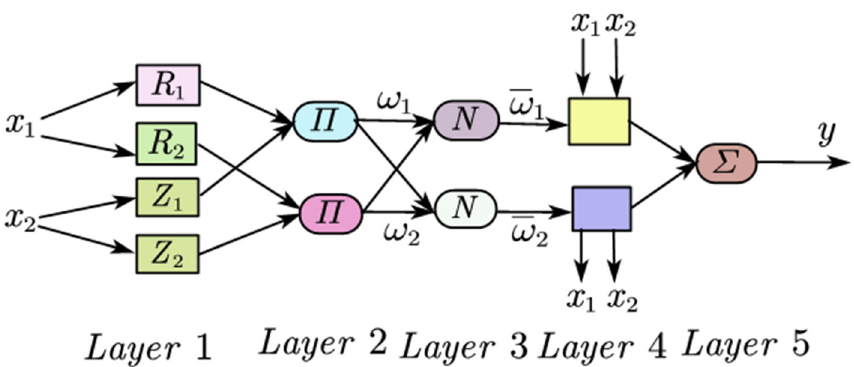
Figure 1. Model structure of adaptive neuro-fuzzy inference system (ANFIS).